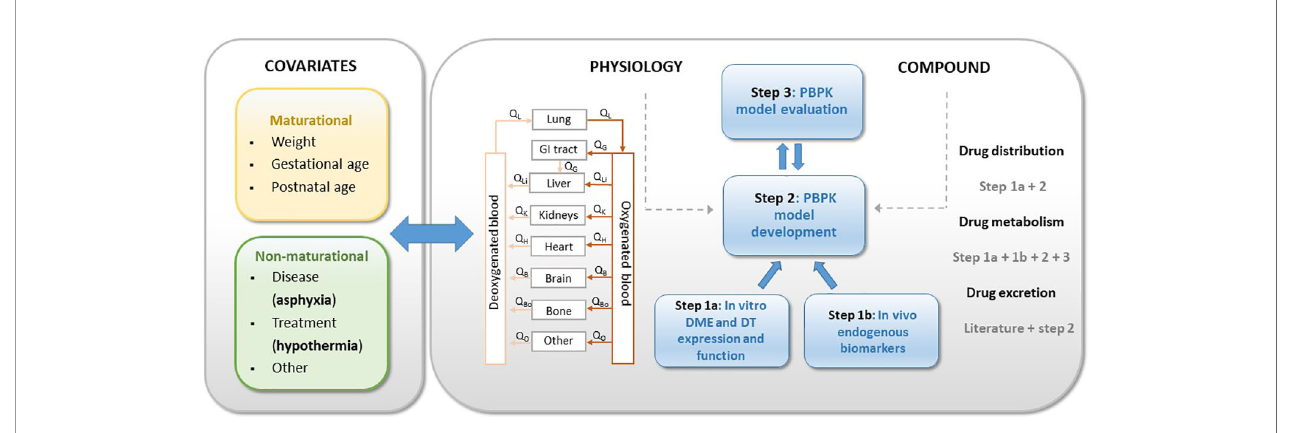
FIGURE 3 | Strategy for neonatal hypothermia PBPK framework development. PBPK, physiology-based pharmacokinetics; DME, drug metabolizing enzymes; DT,